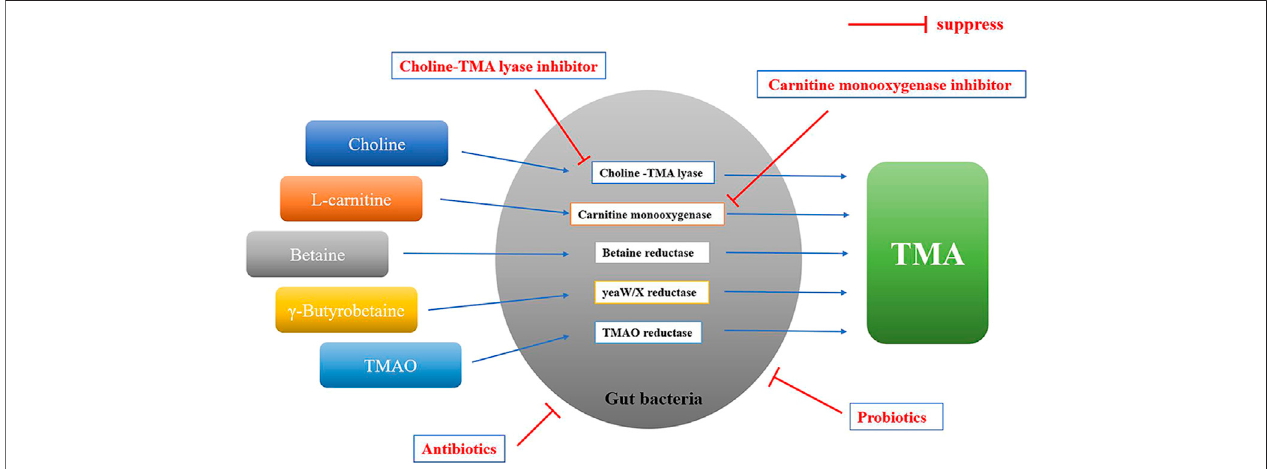
FIGURE 3 | The formation of TMA in gut bacteria. TMA precursors are converted to TMA by different enzyme systems in gut bacteria, including choline-TMA lyase (cutC/D),carnitinemonooxygenase(cntA/B), yeaW/XTMAlyase,betainereductaseandTMAOreductase.GutbacteriainvolvedintheformationofTMA: Bacteroidetes , Firmicutes, Proteobacteria, Fusobacteria, etc.; Probiotics: Lactobacillus plantarum ZDY04, aerogenes ZDY01, Lactobacillus casei, etc.; Antibiotics: metronidazole plus cipro fl oxacin,orvancomycin,neomycin,metronidazoleplusampicillin,etc.;Choline-TMAlyaseinhibitor:DMB,IMC,FMC,etc.;Carnitinemonooxygenaseinhibitor: MMV3,